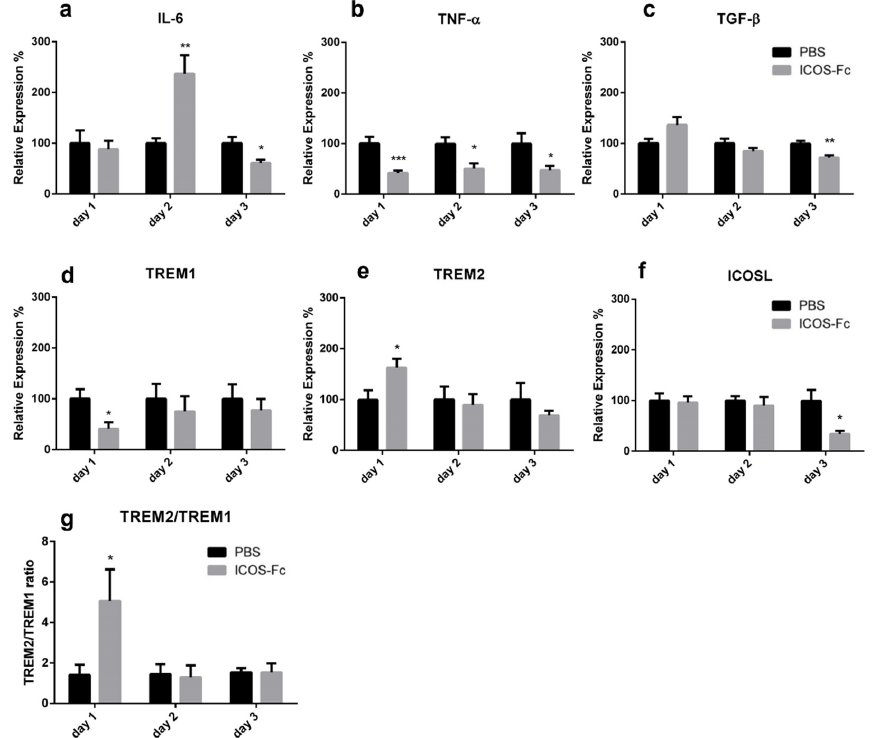
Figure 5. Effect of treatment with ICOS-Fc on the expression of inflammatory molecules in the wound. Expression of IL-6 ( a ), TNF- α ( b ), TGF- β ( c ), TREM1 ( d ), TREM2 ( e ), and ICOSL ( f ) mRNA as assessed by real time PCR at day 1, day 2, and day 3, and expressed as mean ± SE from 3 independent experiments. ( g ) TREM2/TREM1 ratio. Results are expressed as % of the mRNA amount detected in PBS-treated mice at each time point; * p < 0.05; ** p < 0.005; *** p < 0.001, calculated by unpaired Student’s t -test.